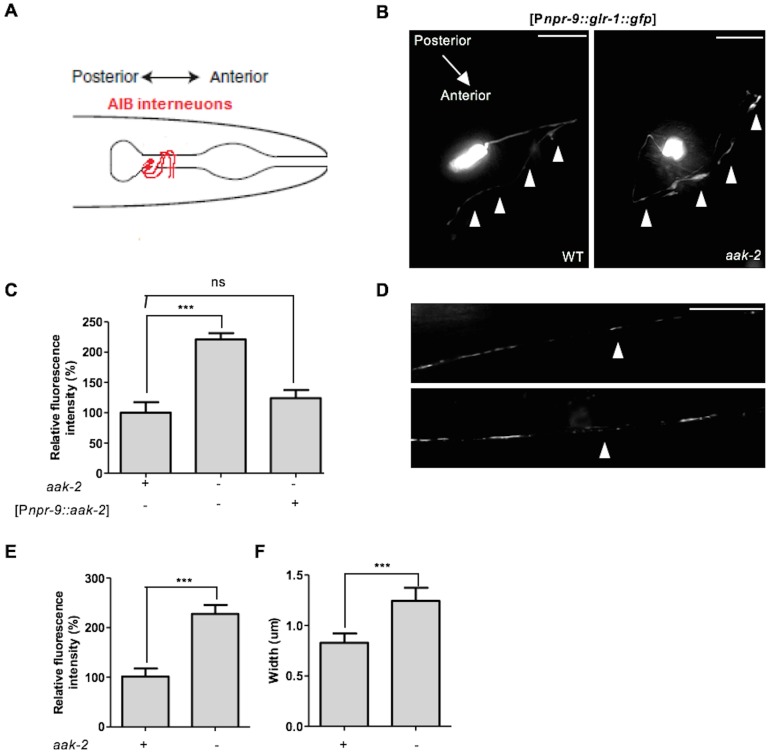
AMPK regulates GLR-1 abundance in the AIB neuronal process and the ventral nerve cord.(A) Schematic representation showing AIB interneurons that extend their processes into the nerve ring. (B,C) Representative images of [Pnpr-9::glr-1::gfp] in the AIB neuronal processes in starved WT and aak-2 mutants (B). GLR-1::GFP level is significantly increased in the AIB neuronal processes in the aak-2 mutants compared to WT animals under starvation condition. Targeted expression of aak-2 within the AIB interneurons rescues the increased GLR-1::GFP level in starved aak-2 mutants (C). At least 3 [Pnpr-9::glr-1::gfp] transgenic lines were separately examined for this experiment (n>20), Error bars represent ± SEM (one-way ANOVA ***p<0.0001). Scale bars are 10 μm. (D,E,F) Representative images of [Pglr-1::glr-1::gfp] in the ventral nerve cord (D). GLR-1::GFP level (E) and puncta width (F) are significantly increased in the ventral nerve cord of starved aak-2 mutants compared to WT animals. (n>20), Error bars represent ± SEM (Student's 2-tailed t test ***p<0.0001). Scale bars are 10 μm.DOI:
http://dx.doi.org/10.7554/eLife.16349.02210.7554/eLife.16349.023Figure 5—source data 1.Measurement of GLR-1 abundance in the AIB neuronal process and ventral nerve cord of WT and aak-2 mutants.DOI:
http://dx.doi.org/10.7554/eLife.16349.02310.7554/eLife.16349.024Figure 5—source data 2.The extent of GLR-1 and EAT-4 colocalization in WT and aak-2 mutants.